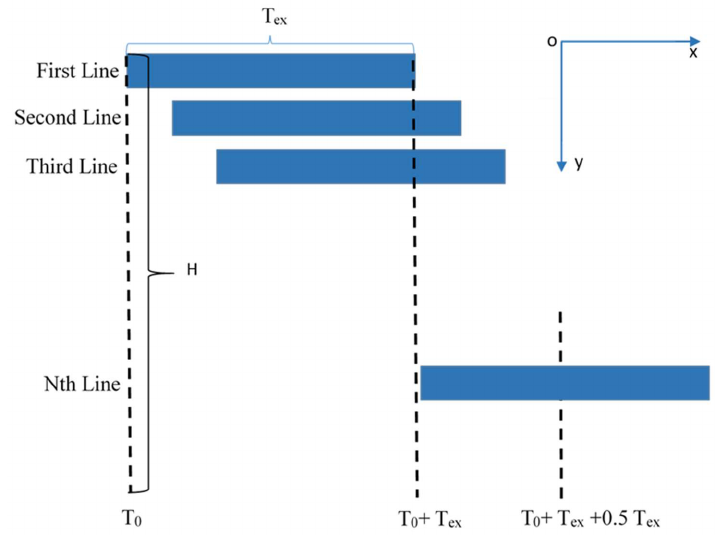
Figure 2. Schematic of rolling shutter exposure process and exposure time.